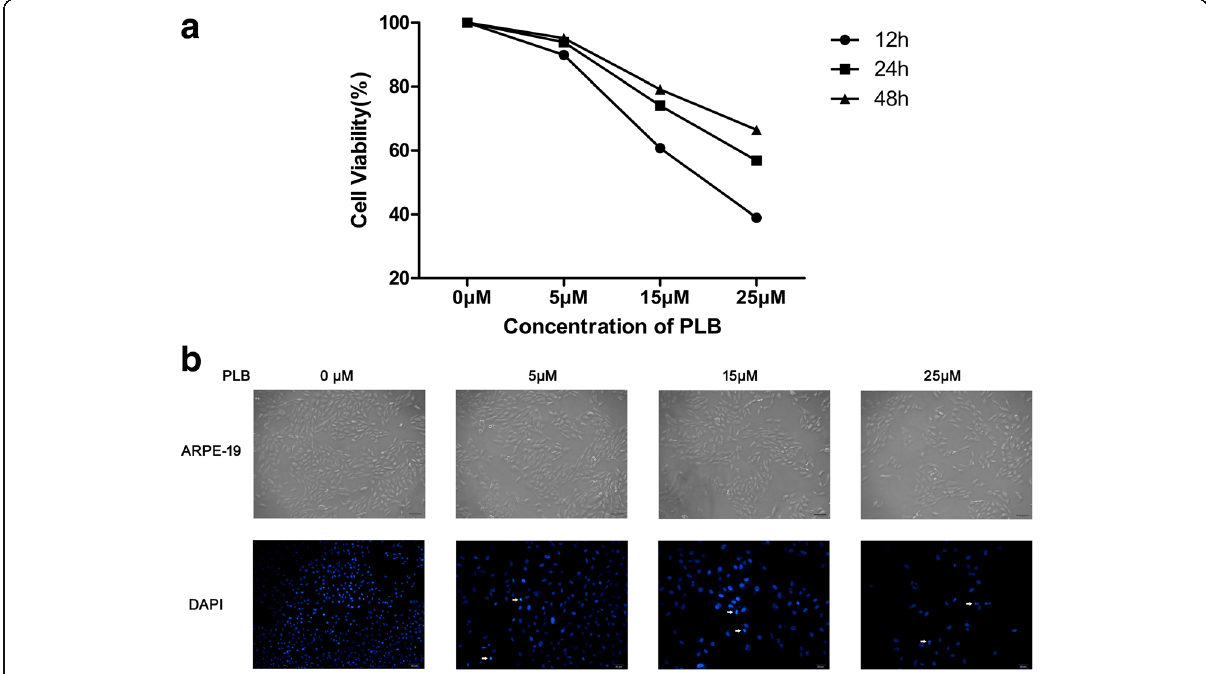
Fig. 1 Effects of plumbagin on the viability of ARPE cells. Notes: ( a ) ARPE cells were treated with indicated concentrations of plumbagin for 24 h and cell survival was measured by MTT assay. The results are expressed as percentage of control; ( b ) The morphological characteristic of cells and nuclears were analyzed with phase-contrast image (Scale bar 50 μ m) and DAPI staining (Scale bar 20 μ m). Arrows indicated apoptotic morphological changes (e.g., chromatin condensation, shrinkage and nuclear fragmentation). Figures were selected as representative data from three independent